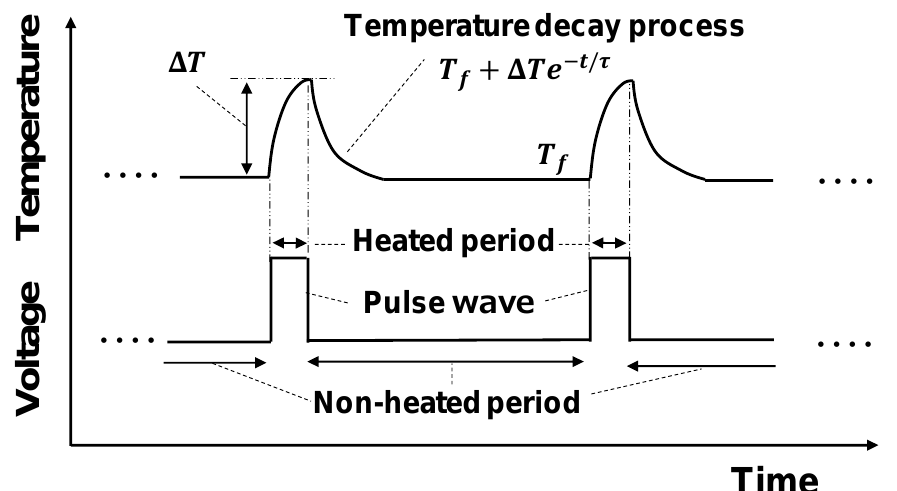
Figure 2. Temperature transients of optical fiber in response to applied Joule-heating pulses.